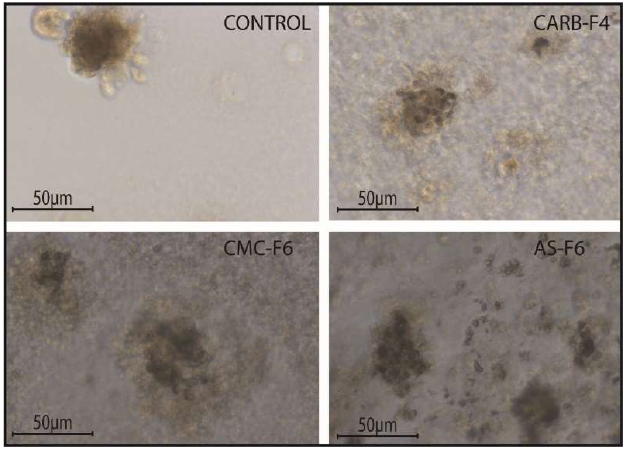
intensity of fluorescence signal; ( c ) area of spheroids expressed in μm 2 . of fluorescence signal; ( c ) area of spheroids expressed in µ m 2 .